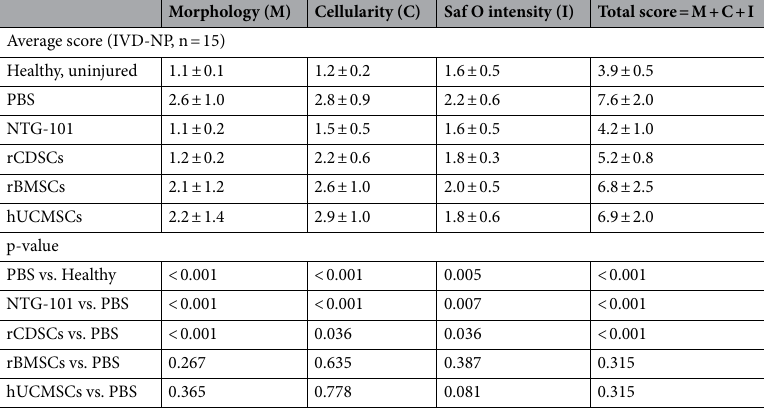
plasmic Sox2 was observed in rBMSCs (Fig. 2). Both rCDSCs and rBMSCs showed nuclear expression of the chondrogenic transcription factor Sox9 with no detectable expression of brachyury (Fig. 2a,b). To confirm the stemness characteristics of the cartilage and bone marrow derived rat MSCs, we differentiated these MSCs into osteogenic, chondrogenic and adipogenic lineages as defined in “Materials and methods”. Both rCDSCs and rBMSCs differentiated into osteogenic, chondrogenic and adipogenic lineages as shown by Aliza- rin red, Safranin O and Oil red O staining respectively confirming their stemness (Supplementary Fig. S1a,b). injected the injured rat caudal IVD-NPs with vehicle (PBS), NTG-101, or MSCs (rCDSCs, rBMSCs and hUC- MSCs) under fluoroscopic image guidance and after humane euthanasia, harvested the IVDs 10-weeks post- injection. We evaluated age matched healthy, uninjured, and treated discs tissue sections for histological features and scored them based upon morphology (M), cellularity (C) and Safranin-O staining intensity (I) (Table 1, Fig. 3a–e). Histological analysis showed a significant loss of cellularity in injured IVDs that received PBS (1×) demonstrating a degenerative phenotype (average total score, MCI = 7.6 ± 2.0, p < 0.001, Table 1, Fig. 3a–e). Rat IVDs injected with NTG-101 demonstrated mild/moderate Safranin O staining intensity (average total morphological and cellular intensity representing mild to moderate degeneration with an average total score, MCI = 5.2 ± 0.8 (p < 0.001, Table 1, Fig. 3a–e. In contrast, IVDs injected with rBMSCs showed moderate to severe degeneration i.e., fibrocartilaginous matrix with a loss of cells within the IVD-NP with an average total score, (MCI) of 6.8 ± 2.5 (p = 0.315, Table 1, Fig. 3a–e). Similarly, histological assessment of rat tail IVDs injected with hUCMSCs showed moderate to severe degeneration in IVDs with low cellularity and a fibrocartilaginous matrix (average total score, MCI = 6.9 ± 2.0, p = 0.315), similar to vehicle control (Table 1, Fig. 3a–e).